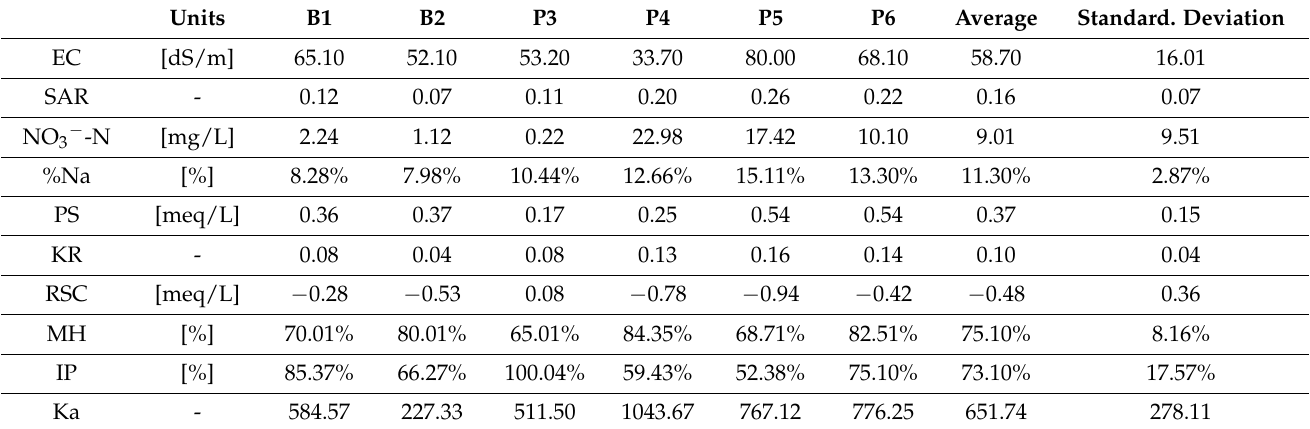
Table 6. Results of the different water quality parameters for agricultural use (July 2020).